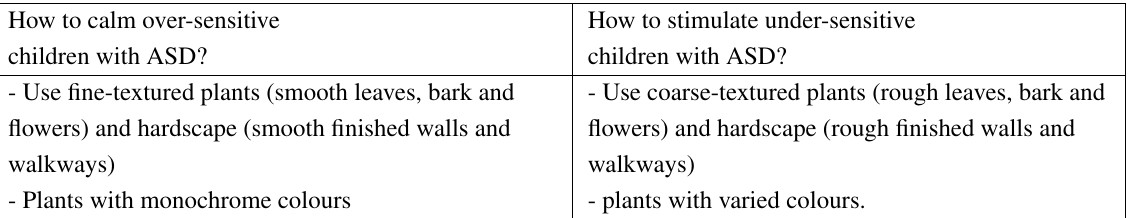
Table 7. How to use texture in creating a specific influence (Wilson,